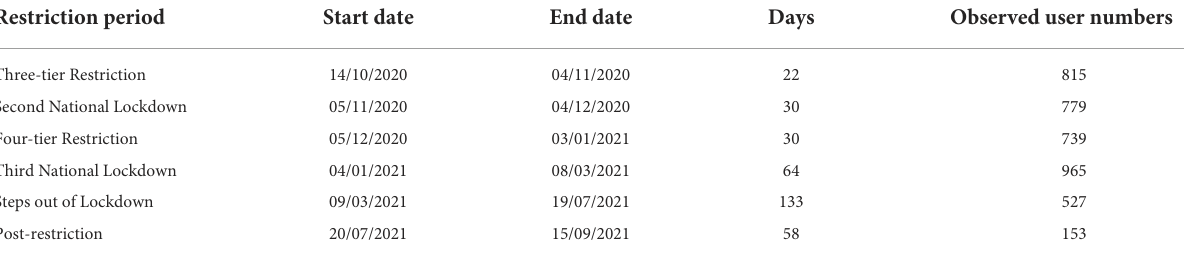
TABLE 3 The days and observed users in the six restriction